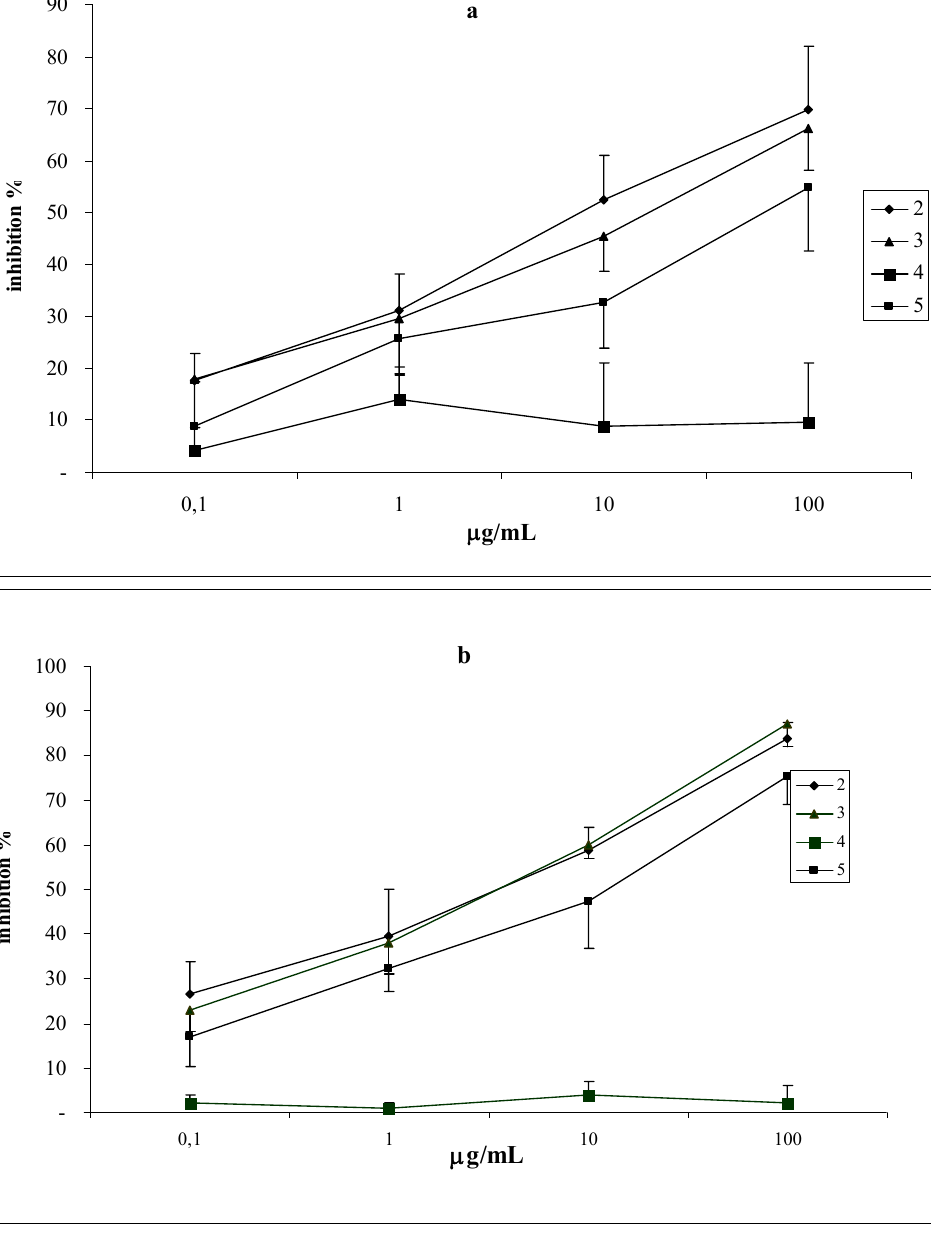
Figure 6 . Inhibitory effects of coumarins on CL emission from resting (a) and PMA-stimulated (b) human whole blood leukocytes. Values are expressed as percent inhibition (mean ± S.D.).